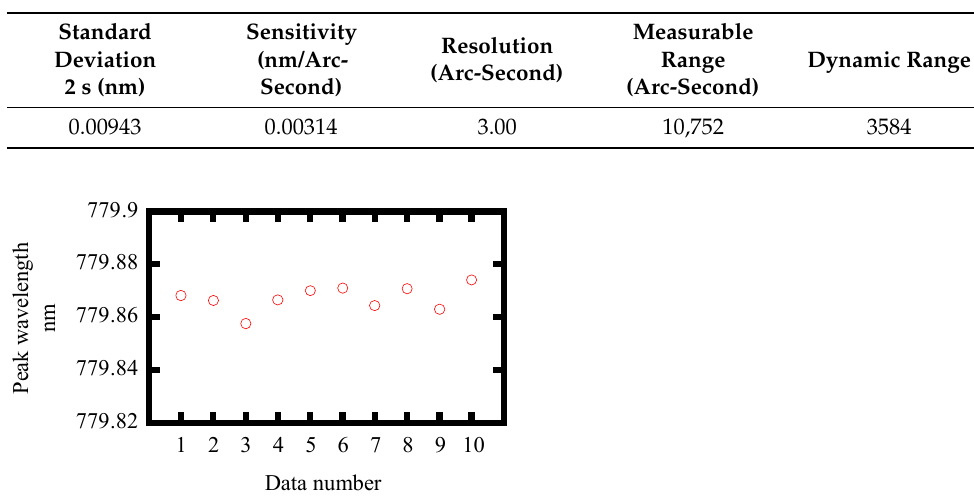
Table 5. The experimental results of the proposed angle measurement system.